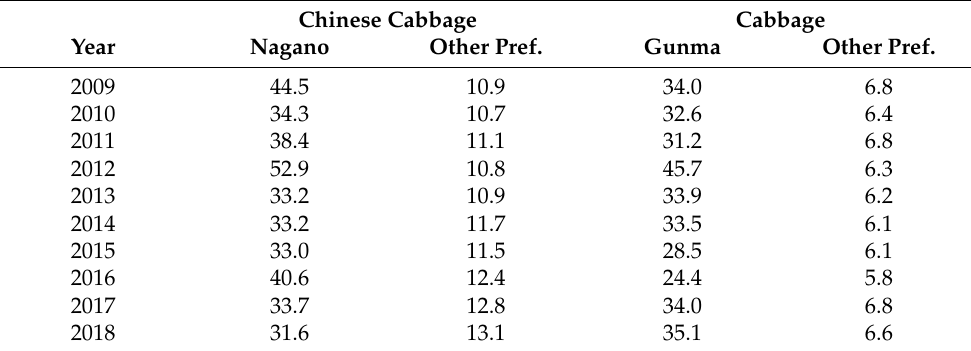
Table A2. Trends of yield of not-for-sale Chinese cabbage and